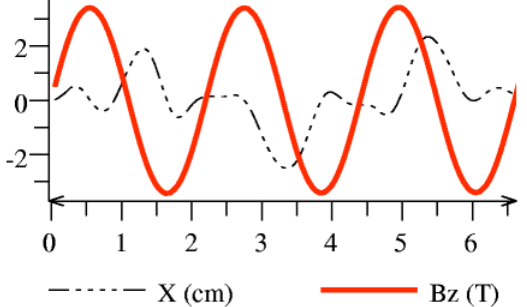
FIG. 2. (Color) x (cm) vs z (m) in three cells of the FOFO cooling channel. The dashed line is a projection of the reference particle’s motion (note the incoherence of the Larmor rotation with respect to the magnetic field period). 041301-4